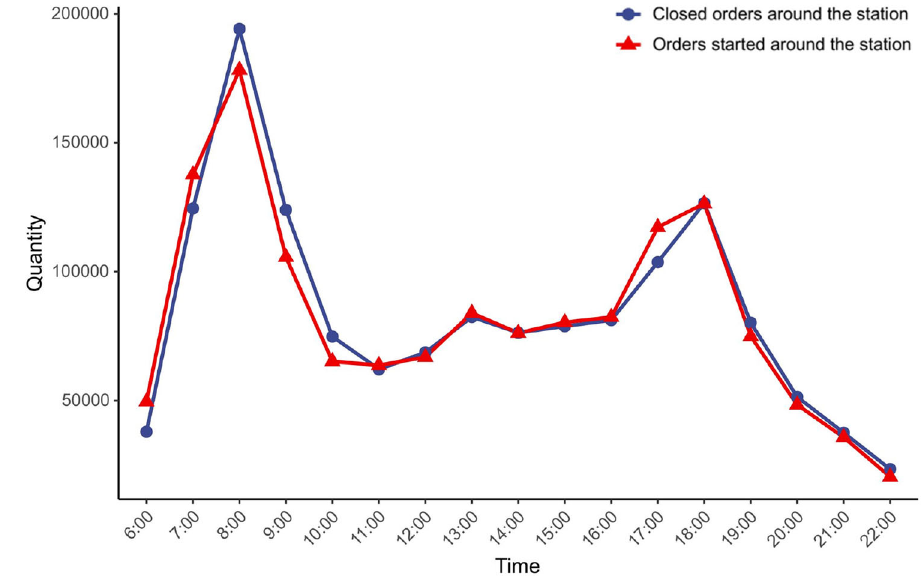
Fig. 4 Usage of shared bicycles around urban rail transit